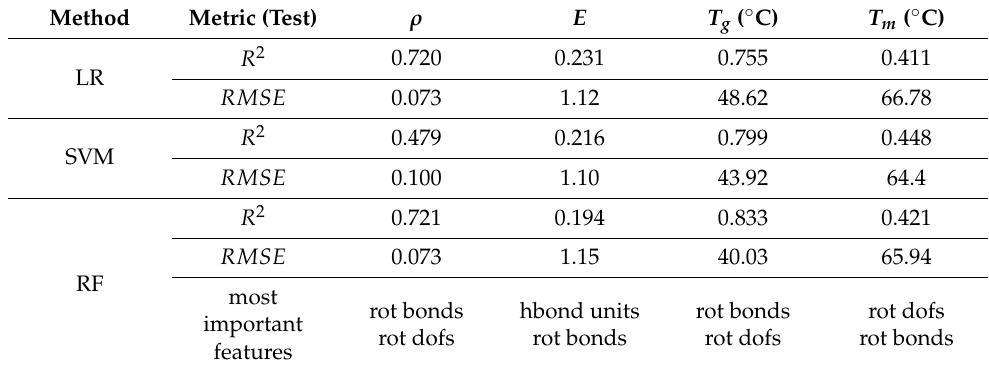
Table 3. The model fit data and the most important features for each of the properties using interpretable QSPR fingerprints. The most important features are based on normalized feature sets.